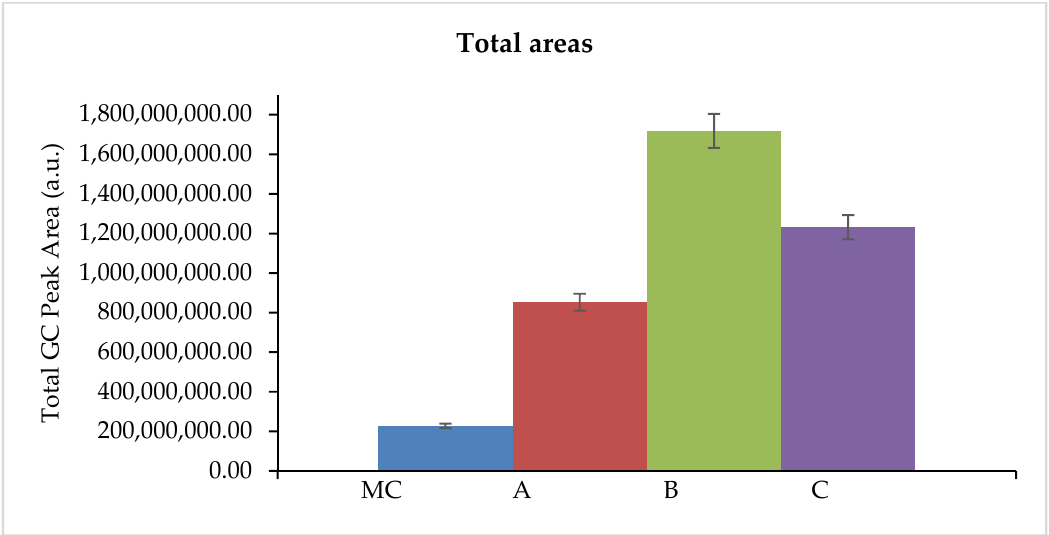
Figure 5. Total areas obtained by HS-SPME/GC-MS analysis, MC—Commercial rectified concentrated grape must (clarified and diluted until 12.5% of probable alcohol), A—Strain A; B—Strain B; C—Control strain C (strains identified by RFLP-mtDNA).